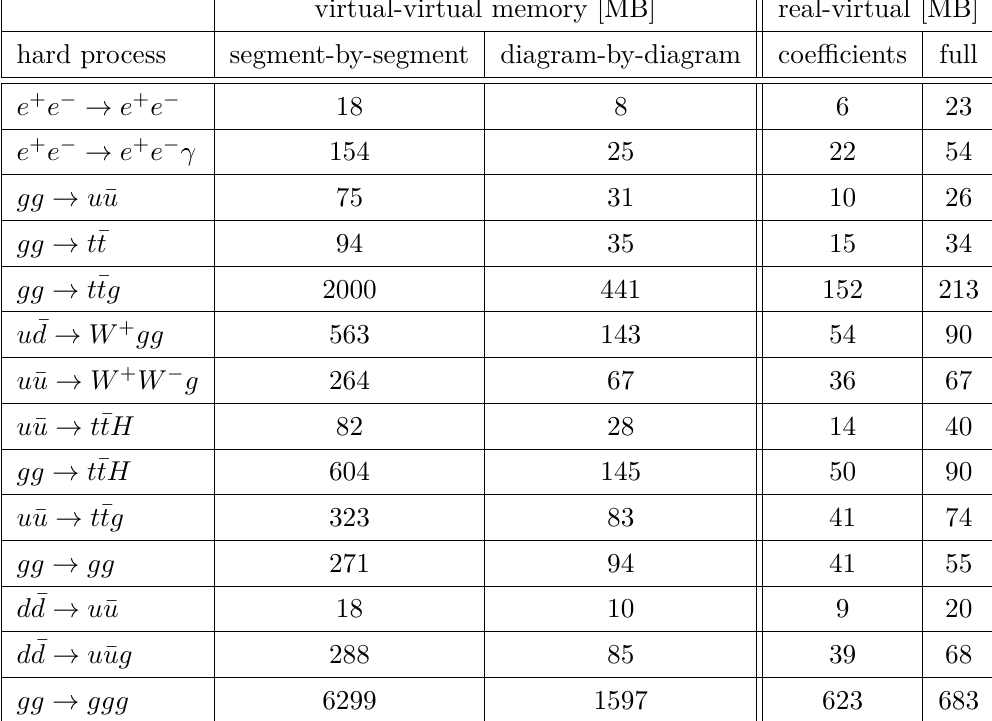
Table 3 . Memory required by the full set of tensor coefficients for the processes of table 2. The two central columns correspond to the construction of two-loop coefficients in the segment-by-segment and diagram-by-diagram approaches (see section 5.3). The last two columns report the memory footprint of the one-loop coefficients for the real-virtual contributions to the same NNLO calculation, as well as the memory footprint of the full real-virtual calculation, including the reduction and evaluation of the tensor integrals with Collier . For these the public OpenLoops 2 program with on-the-fly helicity summation was